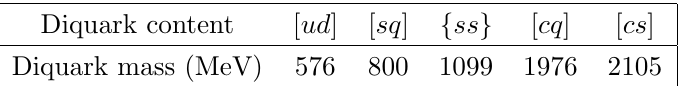
Table 6 . Constituent diquark masses (in MeV) used for calculating the hidden-charm pentaquark mass spectrum. Here, q denotes u - and d -quarks and isospin symmetry is assumed. The brackets [ : : : ] and f : : : g indicate the antisymmetric ( S = 0) and symmetric ( S = 1) spin con(cid:12)gurations of the quarks in the diquark, respectively. (Taken from [62] for light diquarks and from [15] for the heavy-light